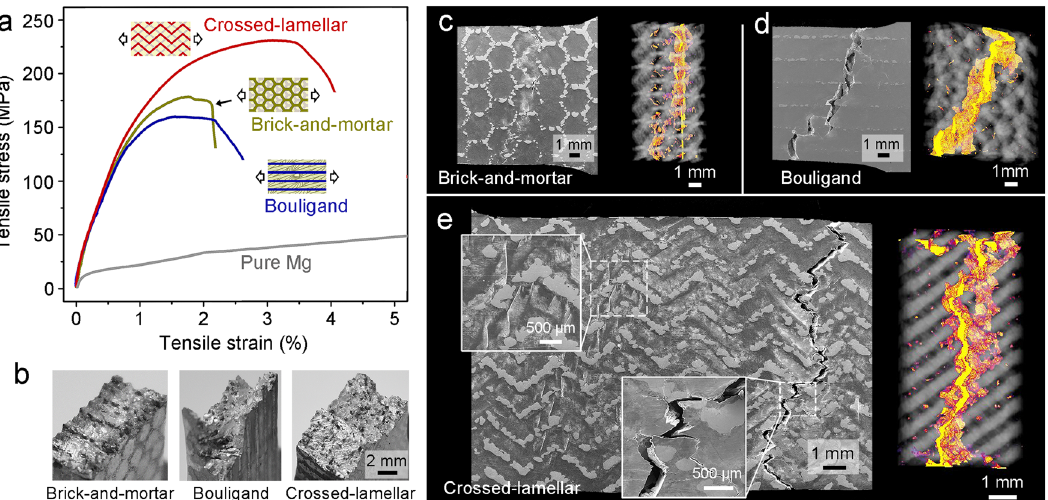
Fig. 3 Uniaxial tensile properties and damage characteristics of the bioinspired Mg-Ti composites with three different architectures. a Tensile engineering stress-strain curves and b overall fracture morphologies of the composites with the loading con fi gurations for tensile tests illustrated in the insets in a . The data for coarse-grained pure Mg are also shown in ( a ) for comparison. c – e SEM images and X-ray computed tomography (CT) volume renderings of the tensile samples unloaded just prior to fracture for the ( c ) brick-and-mortar, ( d ) Bouligand, and ( e ) crossed-lamellar architectures. The CT images were processed by fi ltering out the signals of Mg and highlighting the cracking regions in yellow color. The insets in e magnify the slip bands within Mg and the de fl ection and branching of cracks in the composite with crossed-lamellar